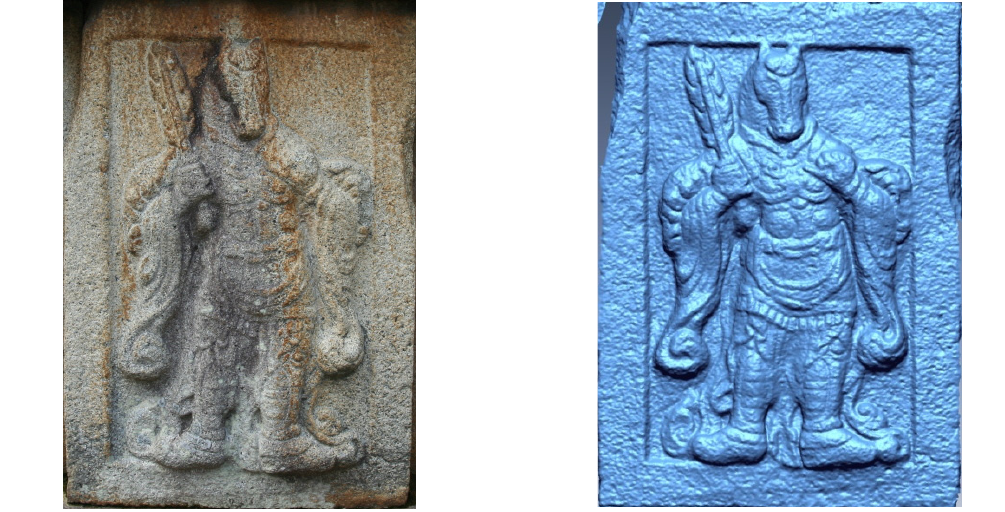
Figure 14. The relief of the horse at a tumulus and its 3D computer reconstruction. These mythical figures, provided with animal heads, superposed over a human war- mongering appearance, were carved in the cylindrical drum of the tumulus at regular intervals with respect to the solar orientation [9], which begins, as we know, with the horse 午 (Wu in Chinese). The celestial horse is aligned with due South as it indicates noon (Figure 13). The correct time and sequence order of the figures is as follows: Rat (24 h), Ox (2 h), Tiger (4 h), Hare (6 h), Dragon (8 h) Serpent (10 h), Horse (12 h), Ram (14 h), Ape (16 h), Bird (18 h), Dog (20 h) and Boar (22 h). It is interesting to note that although the